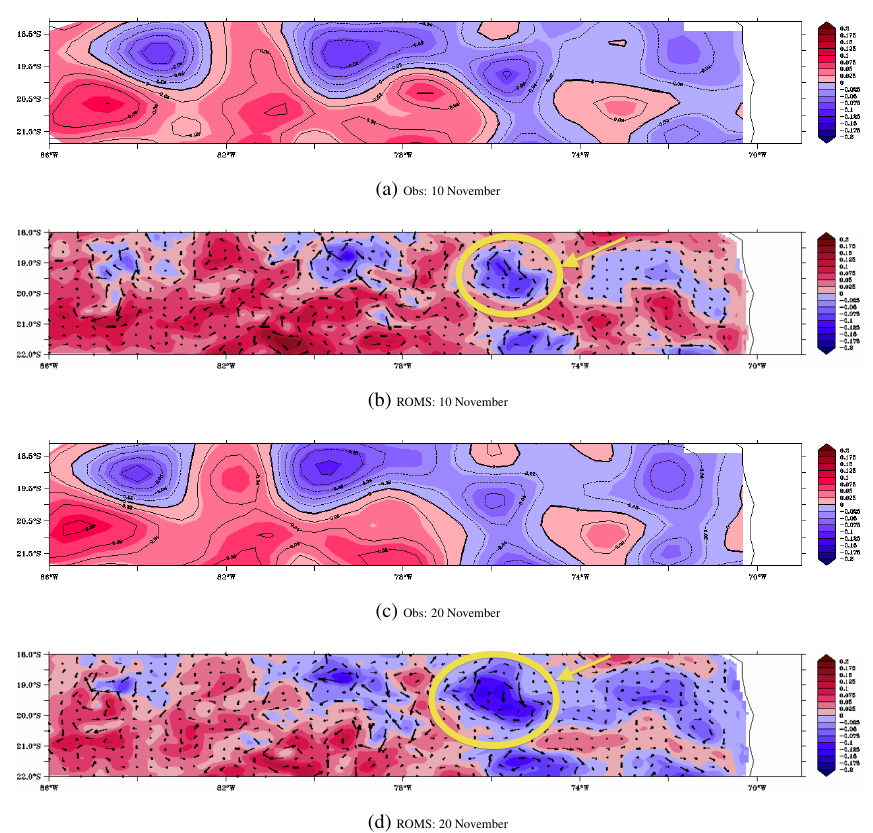
Fig. 9. Sea level anomaly (in meters) from AVISO mapped fields in the (a) and (c) and from the ROMS ocean state estimate in (b) and (d) . The velocities from the model are overlaid on the sea level anomaly contours to reveal cyclonic and anticyclonic eddies.